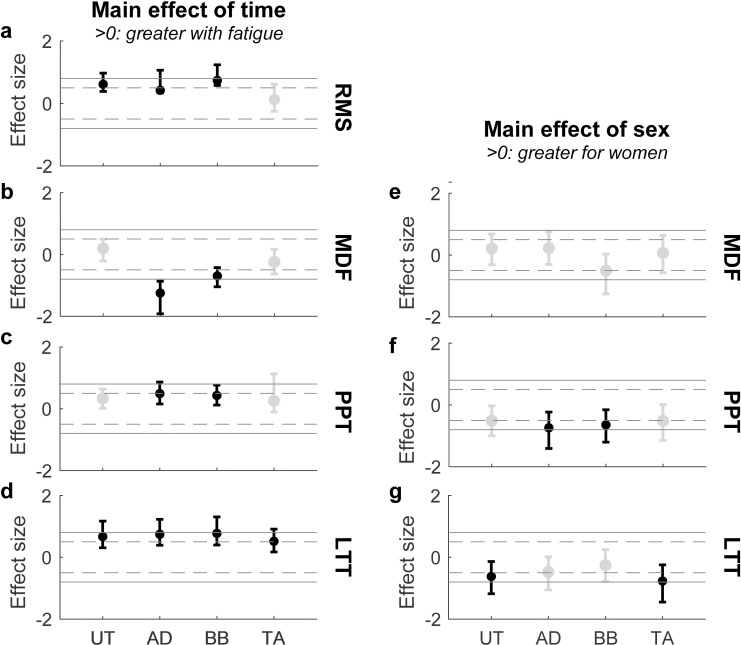
Summary of results for motor and sensory variables.Time and Sex related effect sizes for the EMG root mean square (RMS: a), EMG median frequency (MDF: b, e), pressure point threshold (PPT: c, f) and light touch threshold (LTT: d, g) variables. Dashed and full grey lines indicate thresholds for moderate (Cohen’s D = ± 0.5) and high (Cohen’s D = ± 0.8) effect sizes, respectively. Black and gray markers indicate significant and non-significant main effects, respectively. Error bars represent 95% confidence intervals.